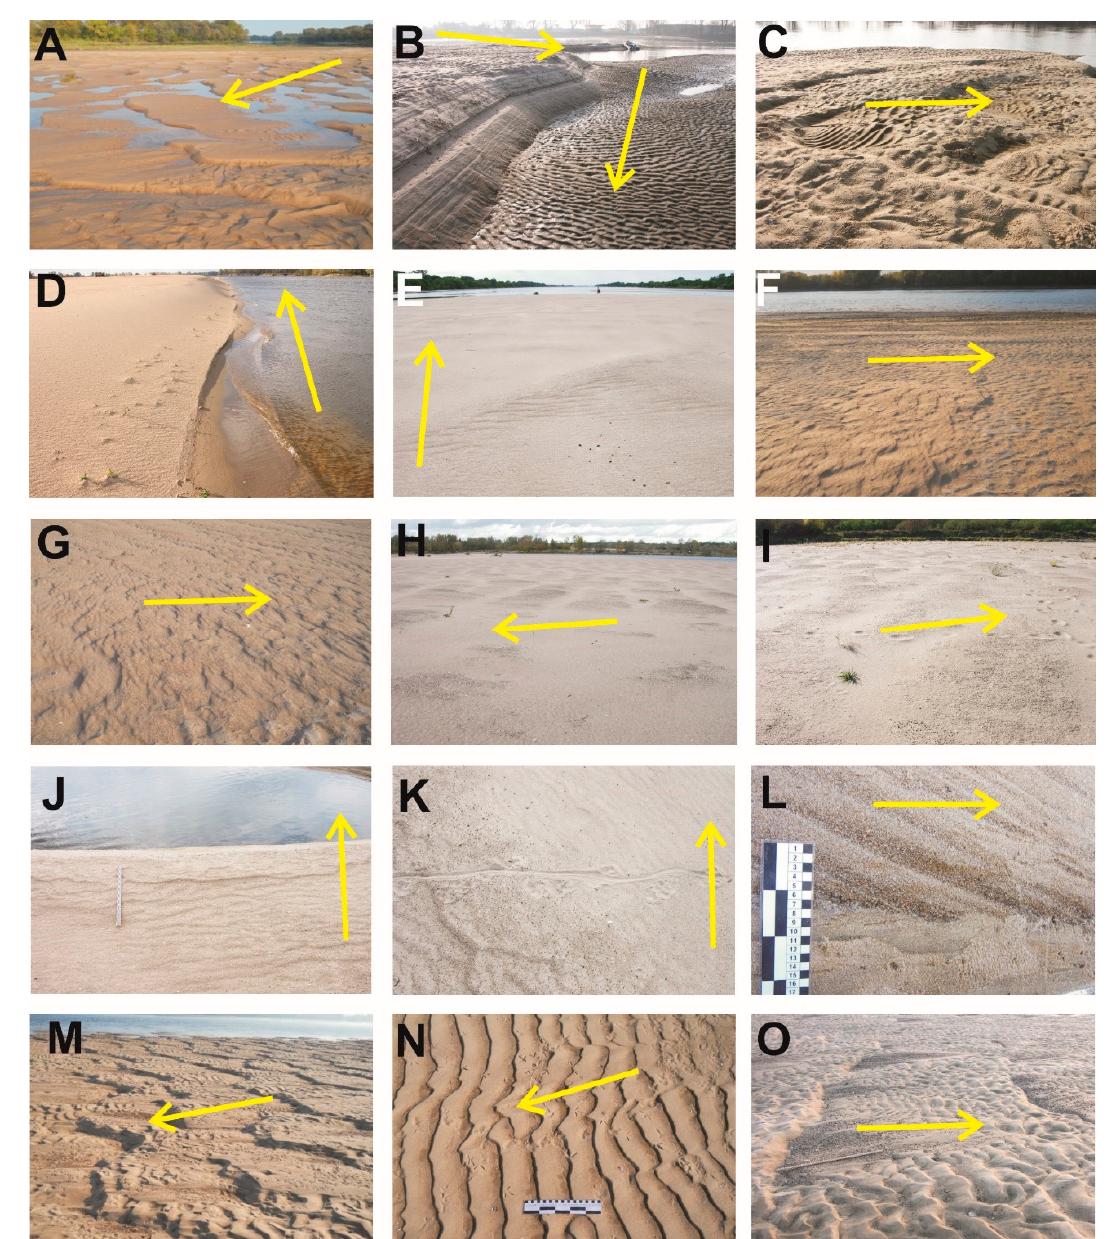
Figure 13. Types of bedforms on channel bars. The yellow arrow marks the water flow. ( A )—the surface of the bar after lowering the water level with clear freshly formed 2D dunes, ( B )—bar surface during lower flow regime, ( C )—clear freshly formed 3D dunes with parasitic ripples on their surface, ( D , E )—aeolian processes on bars, ( F , G )—aeolian erosion of parasitic ripples, ( H , I )—aeolian erosion and accumulation of 2D dunes and 3D dunes, ( J )—coarsest-grained aeolian deposits (granule ripples), ( K )—traces of a beaver on the bar, ( L )—large-scale cross-stratification, ( M – O )—typical fresh bedforms on the analyzed bars.